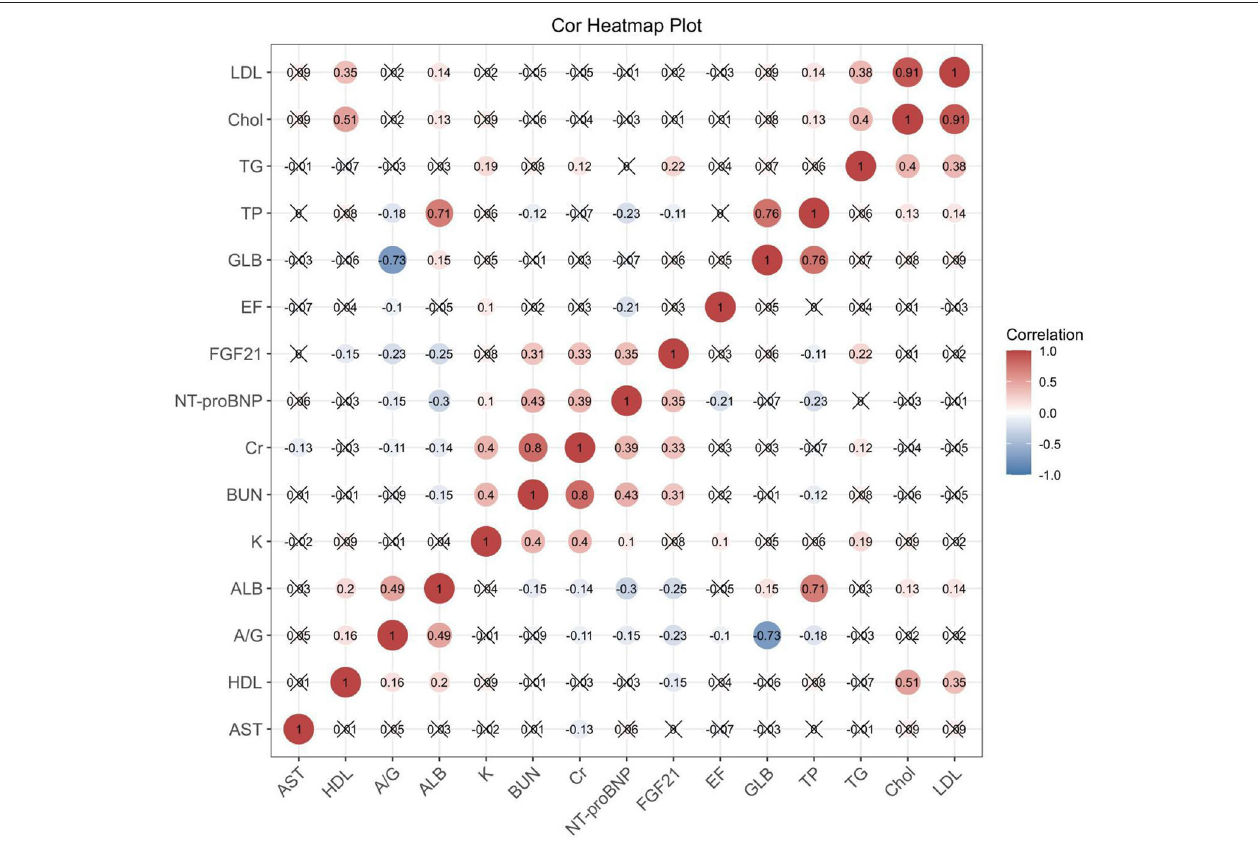
FIGURE 3 | Correlation heat map shows the correlation between serum FGF21 and biochemical parameters, BNP, and EF values in AHF patients. Those with statistical significance ( p < 0.05) are presented as dot plots. ALB, albumin; A/G, albumin/globulin; AST, aspartate aminotransferase; BUN, blood urea nitrogen; Cr, creatinine; Chol, cholesterol; GLB, globulin; HDL, high-density lipoprotein; LDL, low-density lipoprotein; NT-proBNP, N-terminal brain natriuretic peptide; TG, triglyceride; TP, total protein.